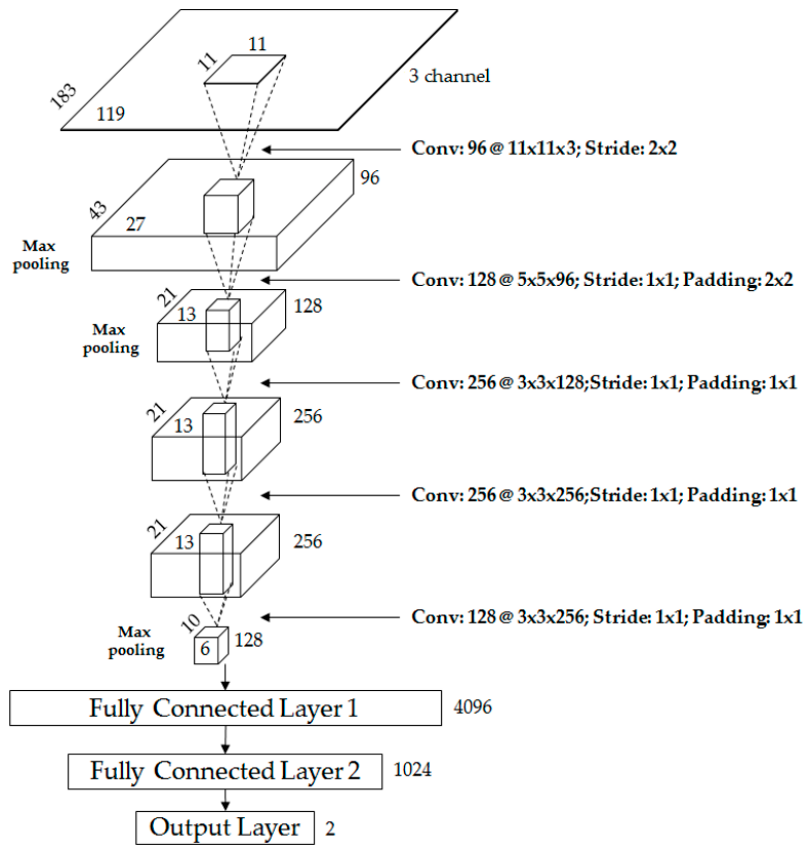
Figure 2. Proposed CNN architecture.